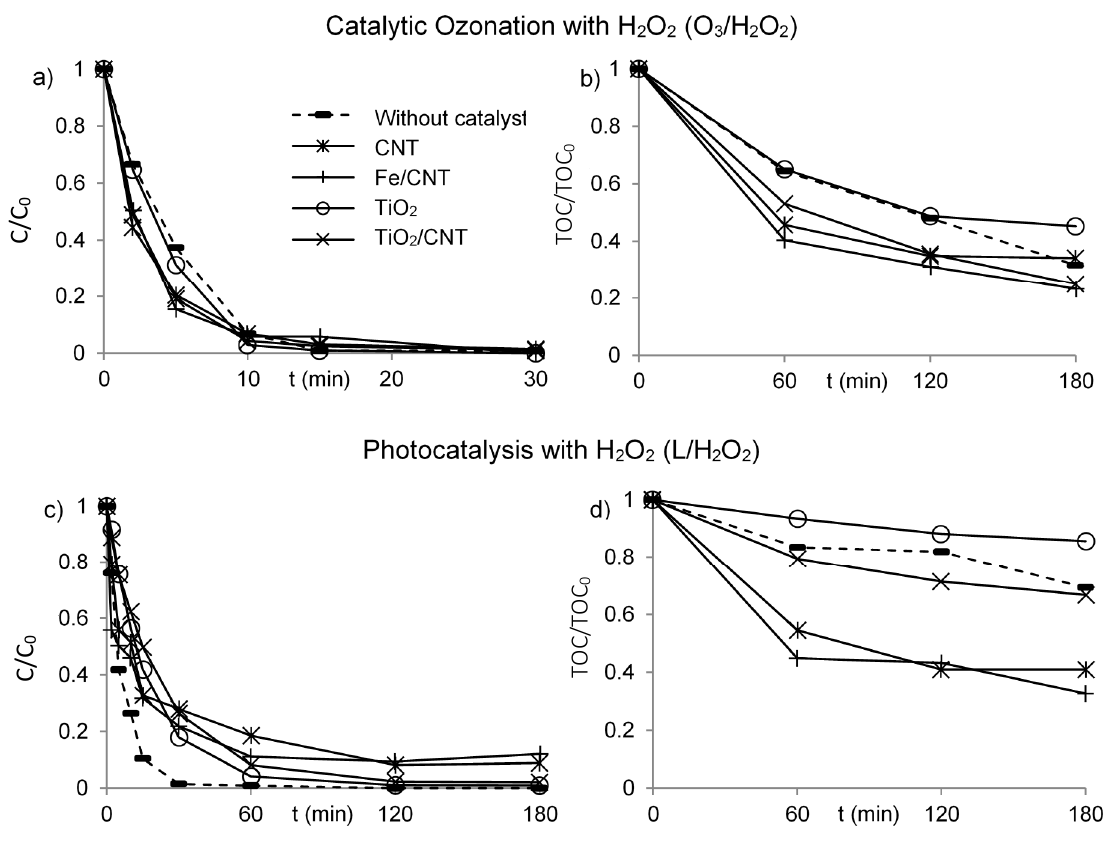
Figure 4. Dimensionless SMX ( a , c ) and TOC ( b , d ) concentration during catalytic ozonation with H 2 O 2 (O 3 /H 2 O 2 ) and photocatalysis with H 2 O 2 (L/H 2 O 2 ) in the presence of CNT, Fe/CNT, TiO 2 , and TiO 2 /CNT.